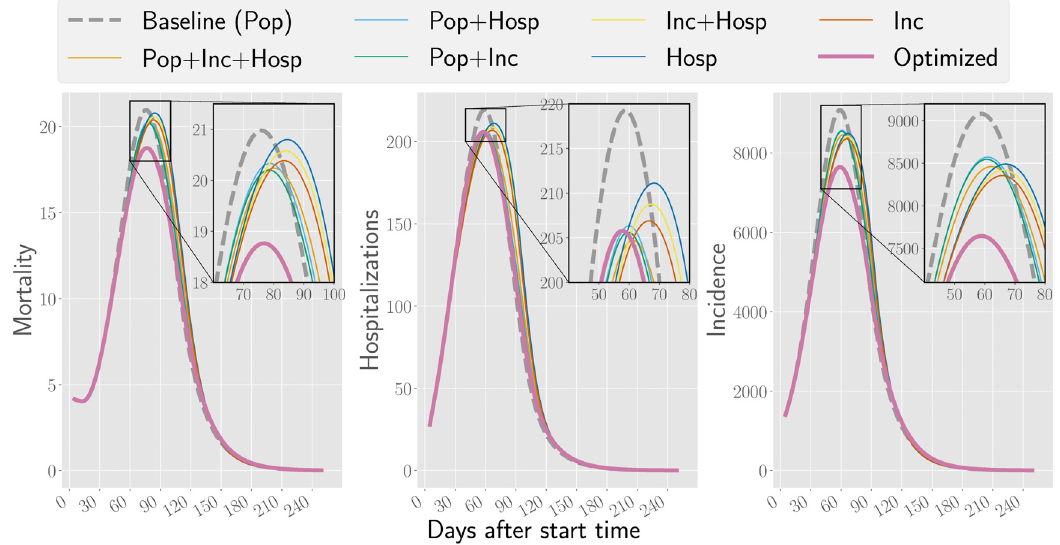
Fig 2. Mortality, hospitalizations, and incidence for the vaccination strategies in Table 2. In this scenario, the effective reproduction number is R eff = 1.5 and the mobility value is τ = 0.5. For other parameter combinations, see S1 File.